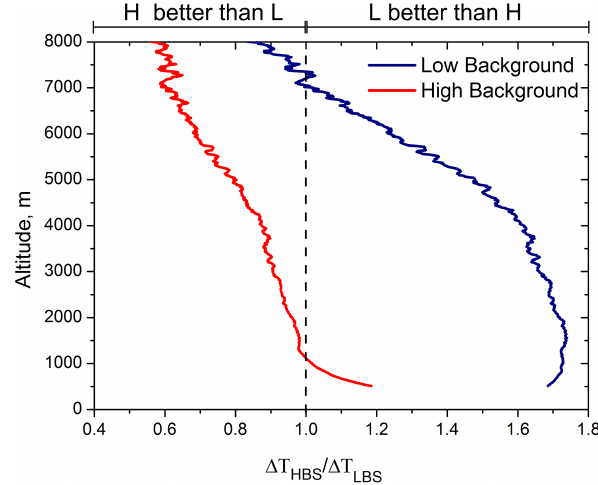
Figure 10. Comparison of the statistical error of the tempera- ture measurements with both settings, (cid:49)T HBS and (cid:49)T LBS , at low- background conditions. The profiles were derived from data col- lected over about 20min (55000 laser shots) and with 105m glid- ing average. Above 7km altitude, the high-background configura- tion shows smaller errors due to the lower atmospheric temperatures at these heights and also the decrease in signal-to-noise ratio.